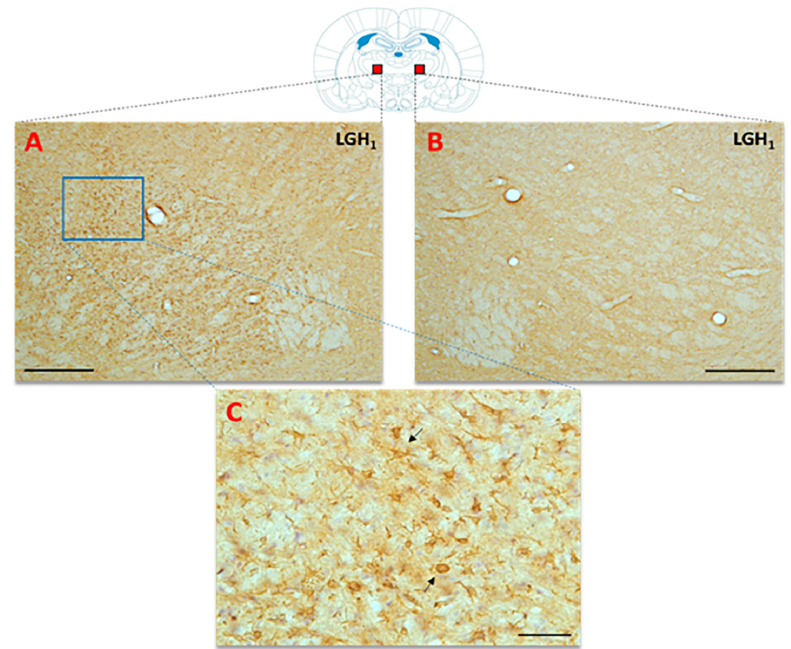
Figure 10. Actin immunoreactivity in the thalamic ventral nucleus (VA/VL complex) ipsilateral to the lesion, from an animal treated with GH. Actin-ir was detected in the thalamic ventral nucleus ipsilateral to the lesion in animals treated with GH ( A ), or vehicle (not shown in this image), immediately after injury, but not in the contralateral thalamic ventral nucleus ( B ). ( C ) Magnification of the blue rectangle shown in ( A ); the black arrows indicate some actin+ cells exhibiting an active microglia/macrophage-like morphology. Scale bars: 200 µm in A and B , and 50 µm in C . Coronal sections at − 1.92 mm from Bregma. Red squares indicate the place where the images were taken.